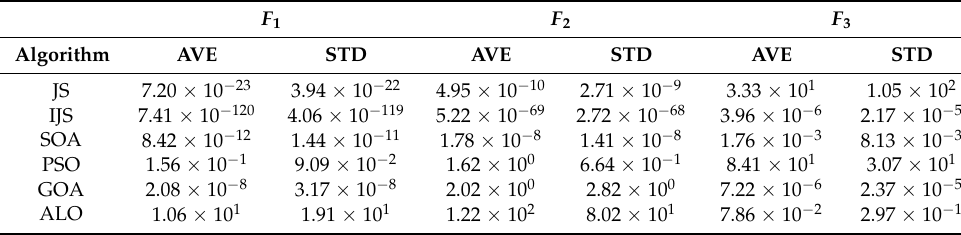
Table 3. The results of each algorithm under the single-peak test function.